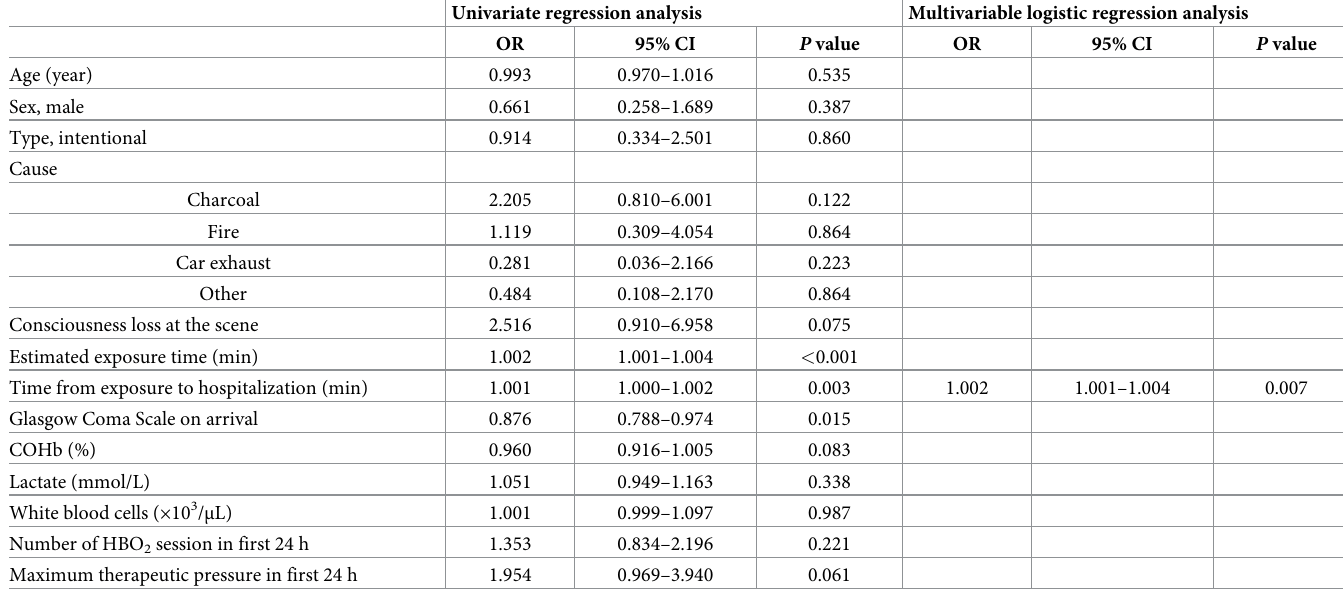
Table 6. Factors associated with the incidence of unimproved